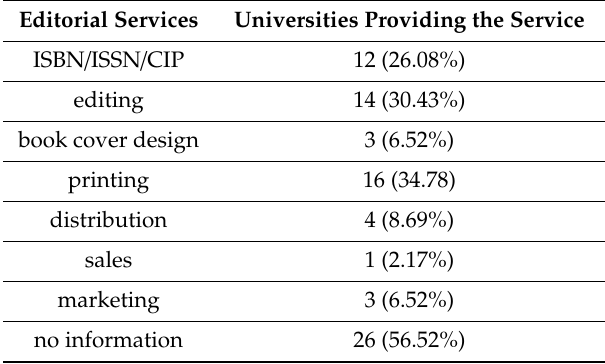
Table 2. Editorial services provided by the press.